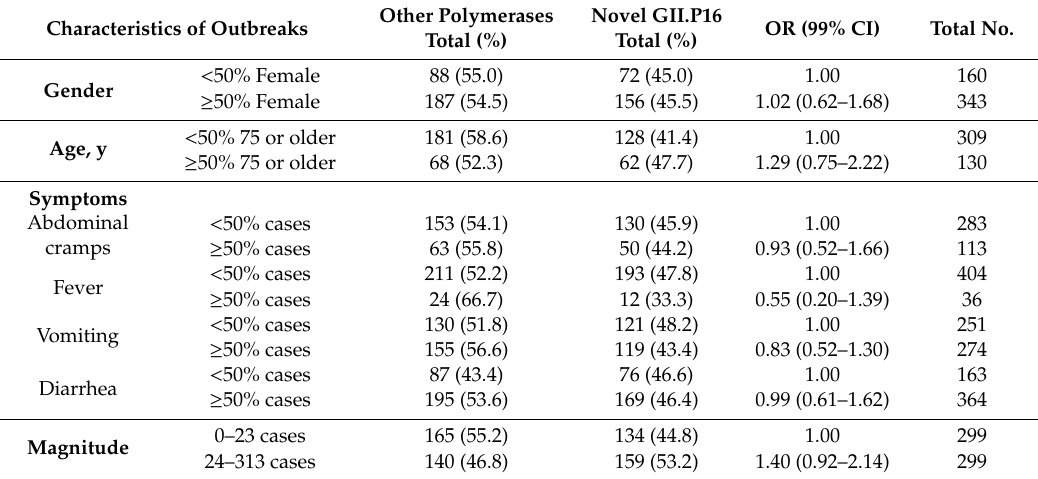
Table 2. Number of norovirus outbreaks by polymerase type, gender, age, symptoms, and magnitude of outbreak